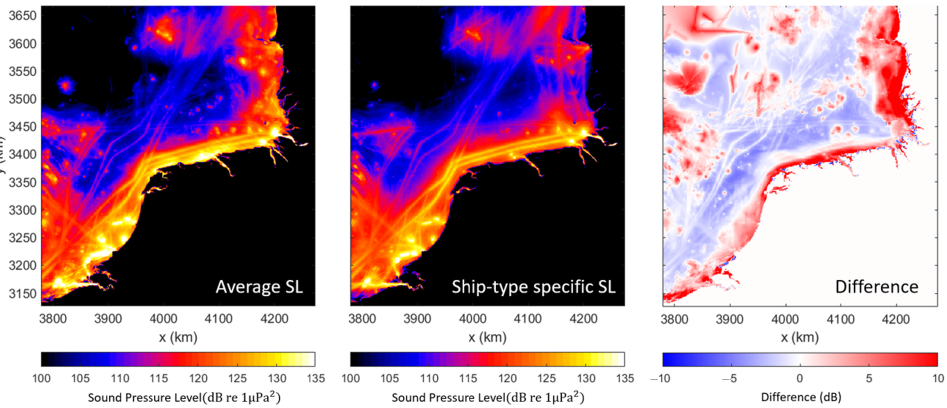
Figure A1. Shipping sound maps for April in test area 1 based on Wales and Heitmeyer ( left ), and ship-type specific ( middle ) source levels are shown for 100 Hz to 10 kHz frequency bands. The differences (dB) between these maps are shown ( right